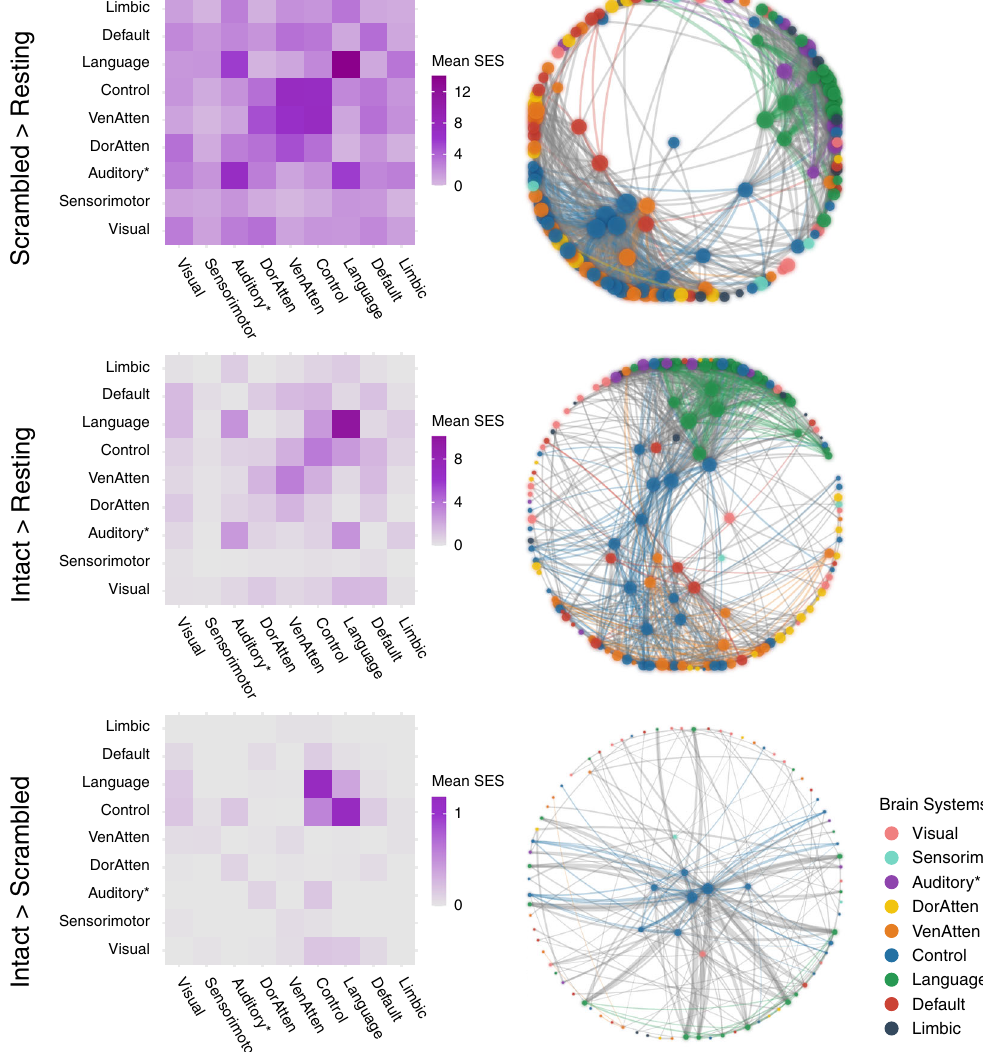
Fig. 5 Network recon fi guration for argumentative comprehension. The fi gure illustrates the signi fi cant ISFC difference ( P < 0.05, FWE corrected) between the scrambled-argumentative condition and the resting-state condition (the fi rst row), the intact-argumentative condition and the resting-state condition (the second row), and the intact- and the scrambled-argumentative conditions (the third row). The left column shows the distribution of all the signi fi cant functional couplings of each contrast within and between brain systems. Each cell indicates the mean standardized effect size (SES) of each contrast, i.e., the ratio between the sum of the SES and the number of the edges in the fully connected situation. The right column shows the network layout, where the nodes represent the brain areas, and the edges represent the signi fi cant interregional ISFC differences between conditions. This layout was generated using the force-directed graph drawing algorithm: strongly connected nodes are clustered together, and weakly connected nodes are pushed apart. For clarity, we only included the top 995 signi fi cant edges with the largest SES (i.e., network density equals 5%, as there were 19,900 potential edges). We included all the signi fi cant edges for the contrast between the intact- and the scrambled-argumentative conditions because there were only 217 signi fi cant edges in total. The size of the nodes denotes the node degree of each brain area. The color of the nodes denotes to which brain system they belong. The width of the edges denotes the SES. Intra-system edges are in the color of that network; inter-system edges are in gray. “ Auditory* “ denotes the network including not only the auditory cortex but also the ventral somatosensory and motor brain areas corresponding to the body parts above the neck. VenAtten = ventral attention; DorAtten = dorsal condition. (Fig. 5, the second row). A direct comparison between illustrates the top 20 functional couplings with the largest SES in the intact- and the scrambled-argumentative conditions was all the brain systems. All these critical functional couplings were conducted by detecting the functional couplings that simulta- between the control system and the language systems. More neously met the criteria (1) Intact Argument > Scrambled speci fi cally, they were the one-to-many connections from the Argument ( P < 0.05, FWE corrected) and (2) Intact Argument > bilateral anterior bank of the intraparietal sulcus (IPS) in the Resting State ( P < 0.05, FWE corrected). The signi fi cant functional couplings were mostly within the control and the language system, including the orbital frontal cortex (Brodmann area 47), systems, especially connecting the control and the language the dorsal lateral part of the temporal pole, the whole length of systems. (Fig. 5, the third row). Not even a single signi fi cant superior temporal gyrus/sulcus (STG/STS, Brodmann area 22), functional coupling fell into the DMN. Supplementary Fig. 8b and the temporoparietal junction (TPJ).